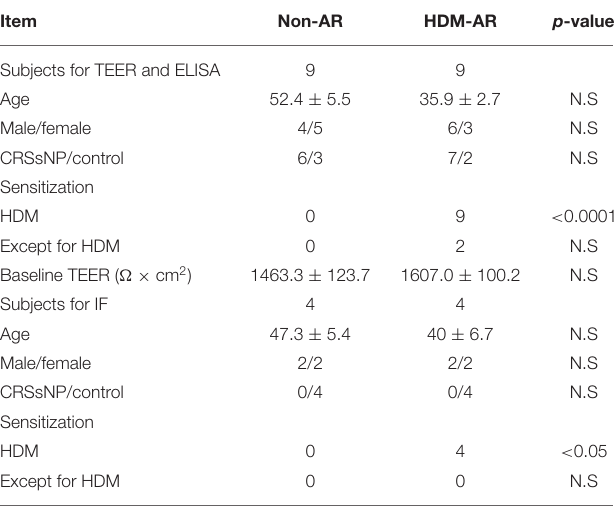
TABLE 1 | Patient characteristics on TEER, paracellular flux and IL-6